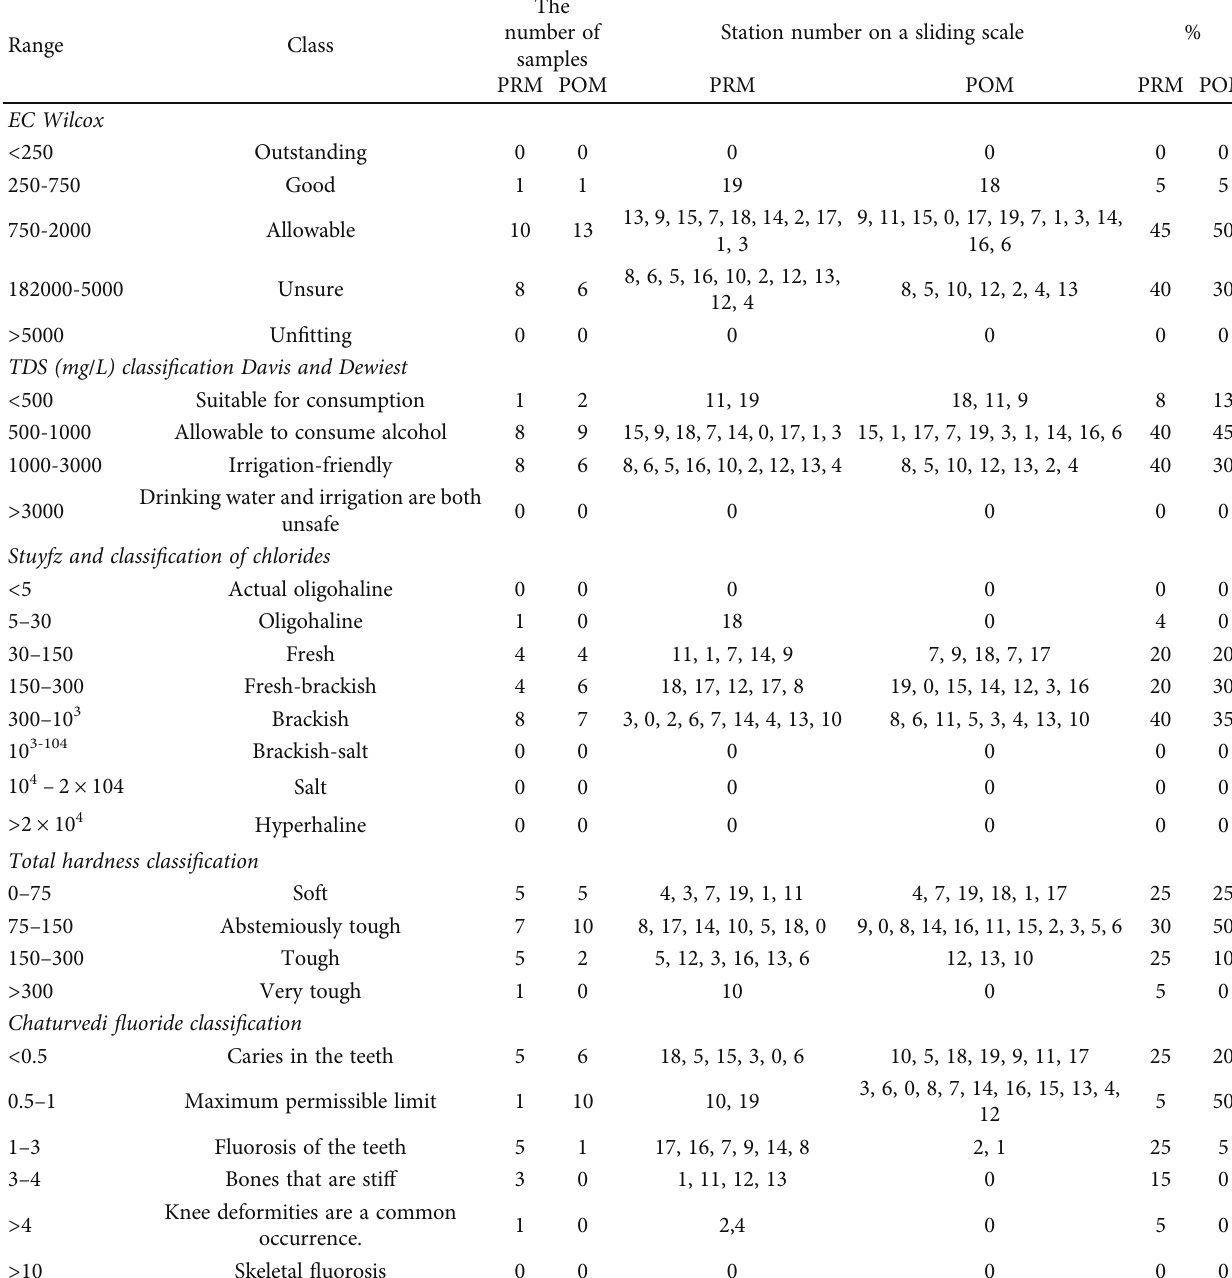
Table 1: EC, TDS, chloride, fl uoride, and TH readings are used to classify groundwater samples.